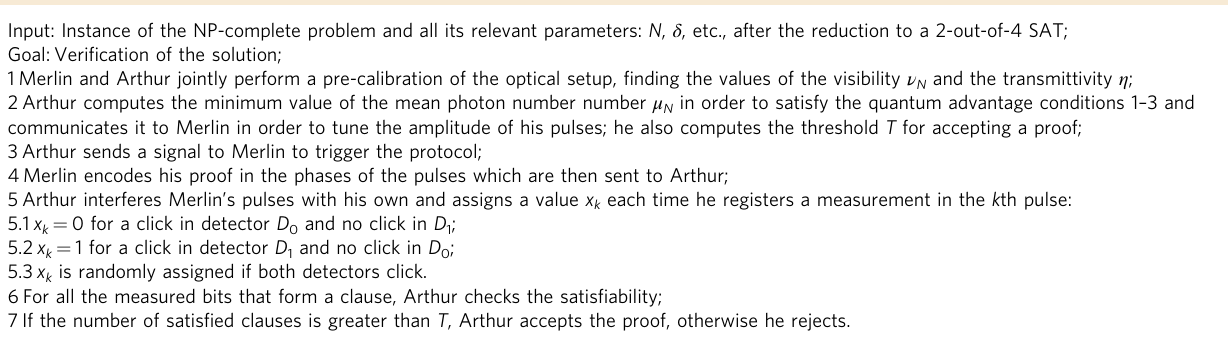
Box 1 Protocol for NP veri fi